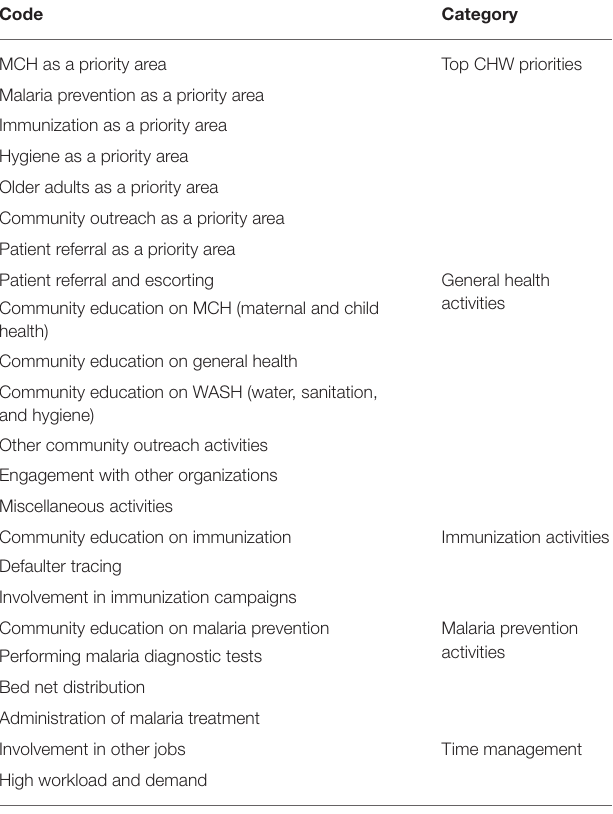
TABLE 2.2 | Codes and categories for Theme 2: “Diverse health responsibilities and competing priorities result in overburdening of CHWs”, qualitative assessment, Western Area Urban, Sierra Leone, 2018.